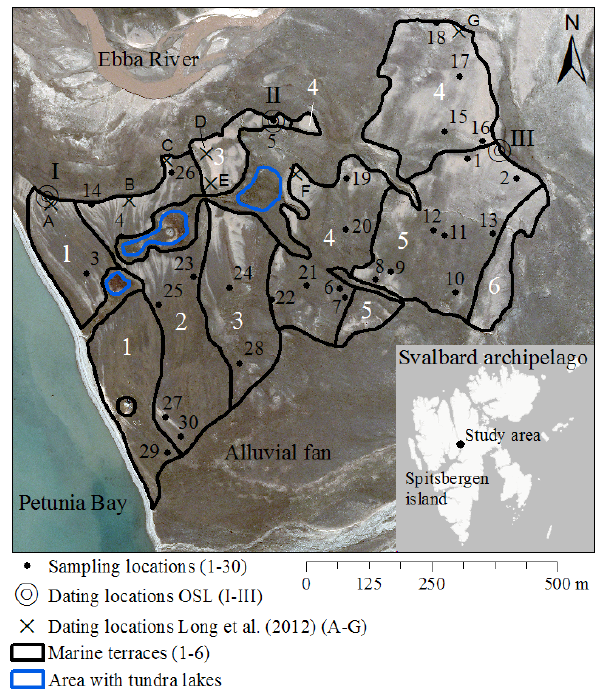
Figure 1. Aerial photograph (summer 2009) of the study area indi- cating the 6 terrace levels (in white numerals), 3 OSL-dating loca- tions (in roman numerals), 30 sampling locations (in black numer- als) and the approximate location of the radiocarbon datings done by Long et al. (2012). Their corresponding dates can be found in Fig. 3. Ridges are recognizable as light (unvegetated) parts of the terraces, while troughs are darker (vegetated). Disturbed areas such as erosion rills, permanently wet depressions and tundra lakes were excluded from the study area. The inset shows the location of the study area on the island of